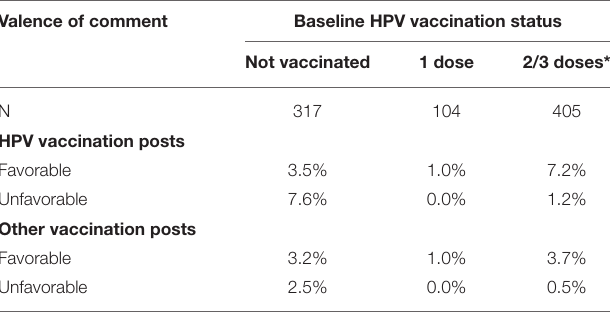
TABLE 2 | Valence of comments to HPV and other vaccination posts by HPV vaccine status of daughter at baseline. Valence of